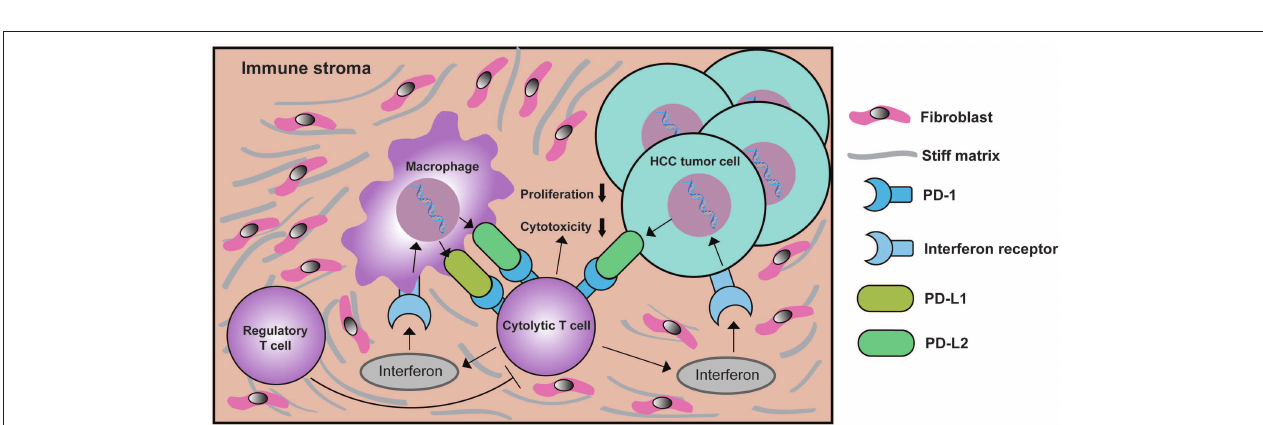
FIGURE 7 | Correlation between PD-Ls and immune/stromal cell infiltration. The proportions of infiltrating immune and stromal cells between HCC subsets stratified by PD-L1 (left panel) and PD-L2 (right panel) expression. Unsupervised clustering shows the consistency between TILs infiltrating patterns and candidate grouping based on PD-Ls expression.